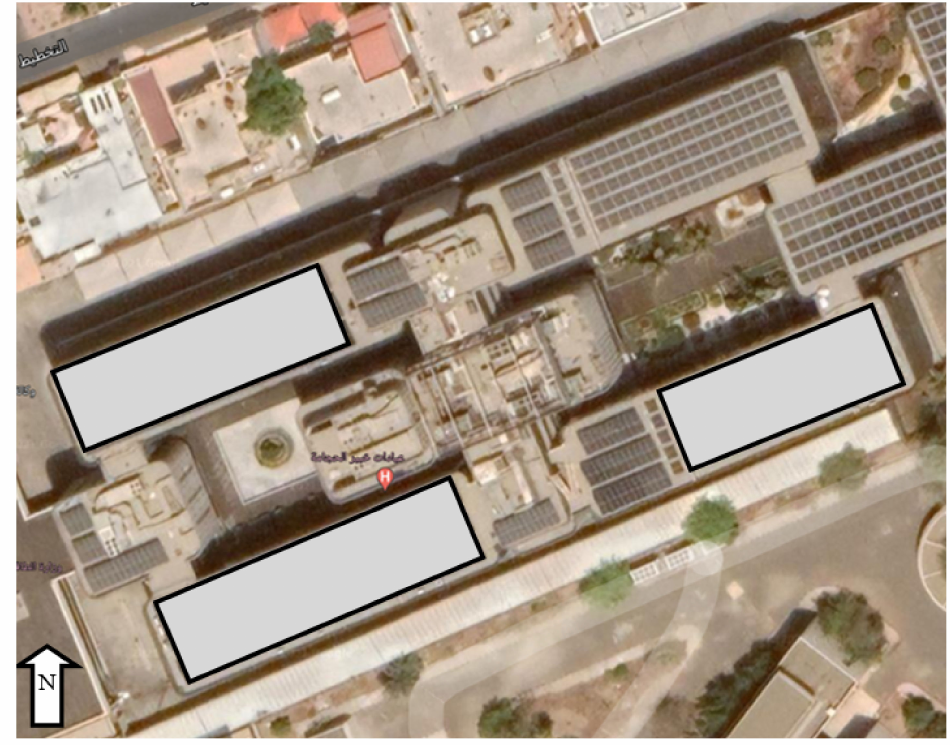
Figure 4. Distribution of the panels in the first